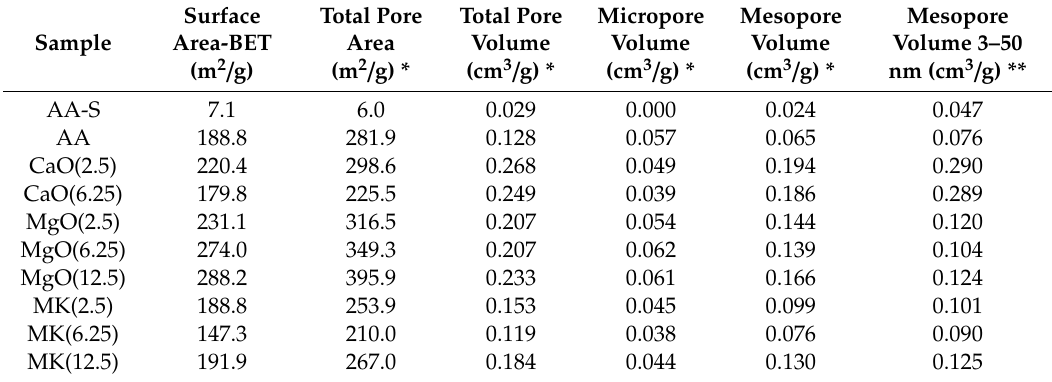
Table 3. Textural properties of D2 samples determined by N 2 physisorption measurement.